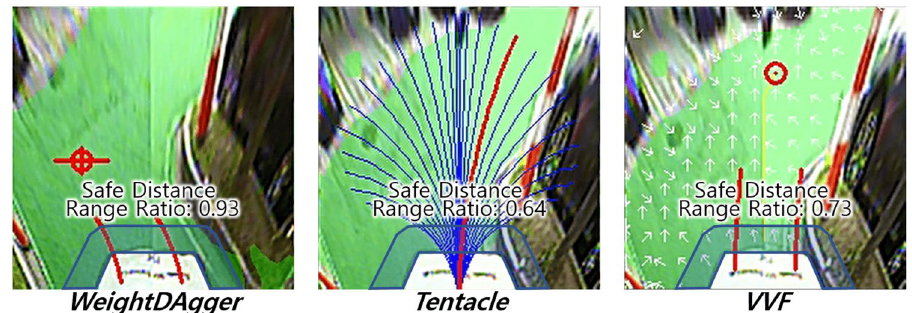
Figure 10. Results of safe distance range ratio; The blue area is the safe distance range, and its ratio is a measure of how much drivable area (green) exist within the blue area.